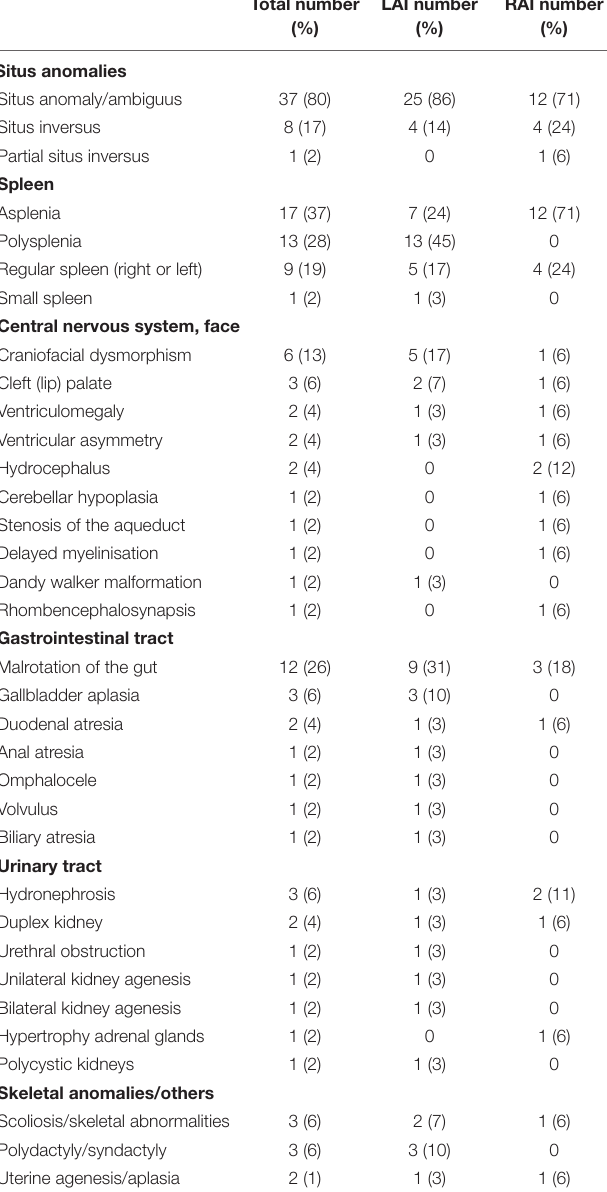
TABLE 3 | Non-cardiac abnormalities among 46 fetuses with left atrial isomerism TABLE 2 | Distribution of cardiovascular malformations among fetuses with left (LAI) ( n = 29) and right atrial isomerism (RAI) ( n = 17) from pre- and post-natal atrial isomerism (LAI) and right atrial isomerism (RAI). imaging studies and autopsy LAI ( n = 29) RAI ( n = 17)